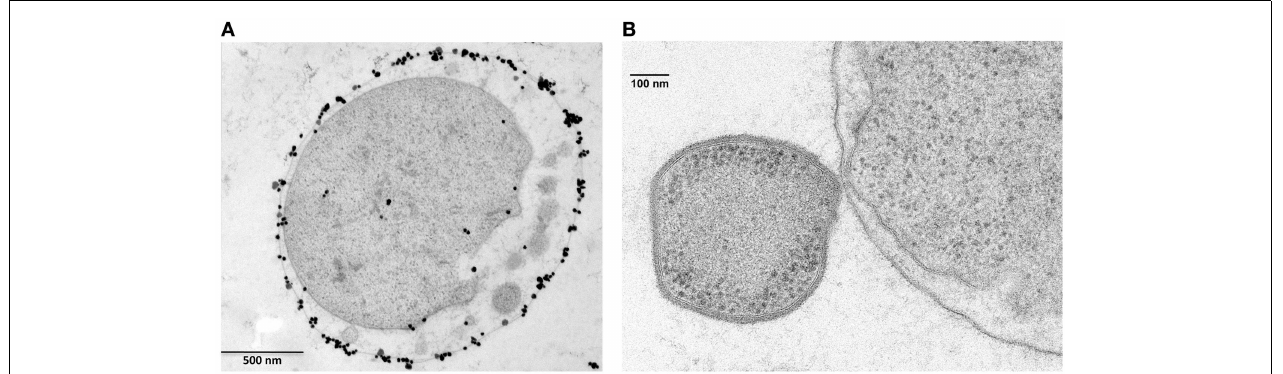
Regensburg, Germany. (B) Electron micrographs of I. hospitalis ultrathin sections. Outer membrane of I. hospitalis and the cell surface of N. equitans in direct contact (Junglas et al., 2008). Image courtesy ofT. Heimerl, H. Huber, and R. Rachel, and image (B) courtesy of H. Huber and R. Rachel, University of Regensburg,